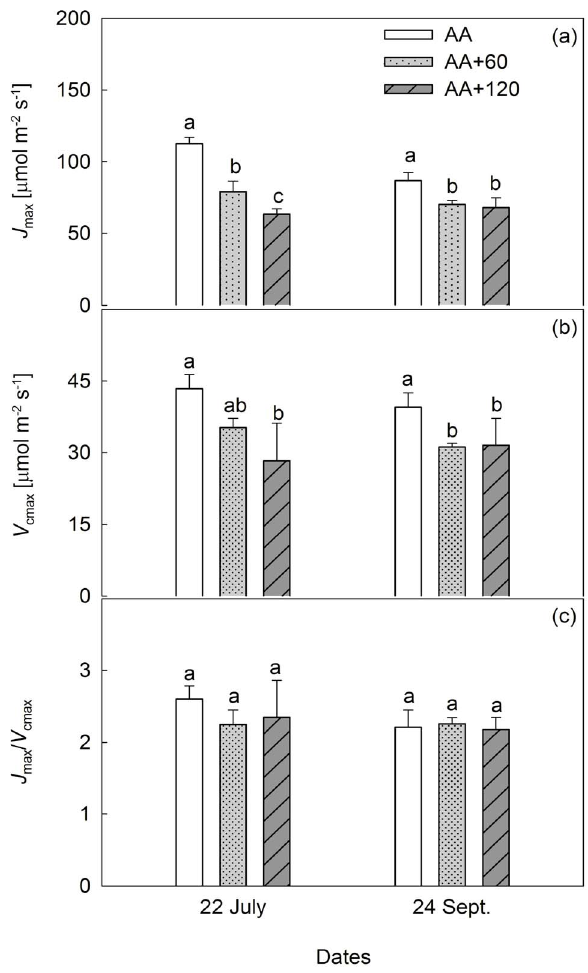
Figure 2. Effects of elevated O 3 on the maximum rates of carboxylation ( V cmax ) and electron transport ( J max ). Vertical bars represent average levels and distinct letters indicate significant differences among O 3 regimes ( n =4) (AA: ambient air; AA + 60: ambient air plus 60 [ppb] O 3 ; AA + 120: ambient air plus 120 [ppb] O 3 ).